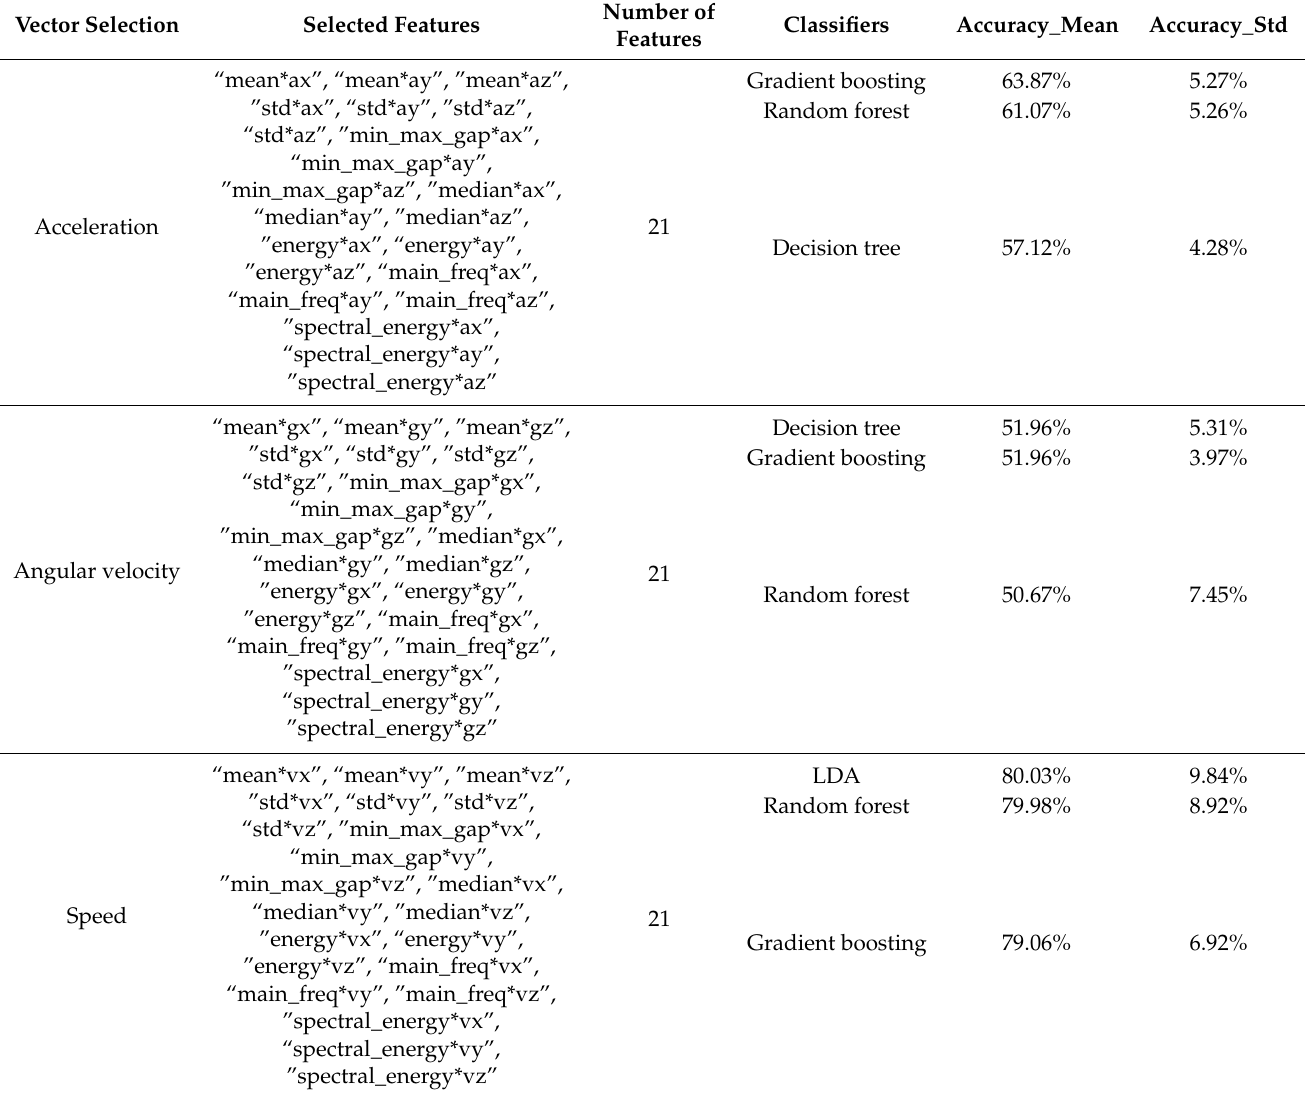
Table 8. Performance of vector-based feature